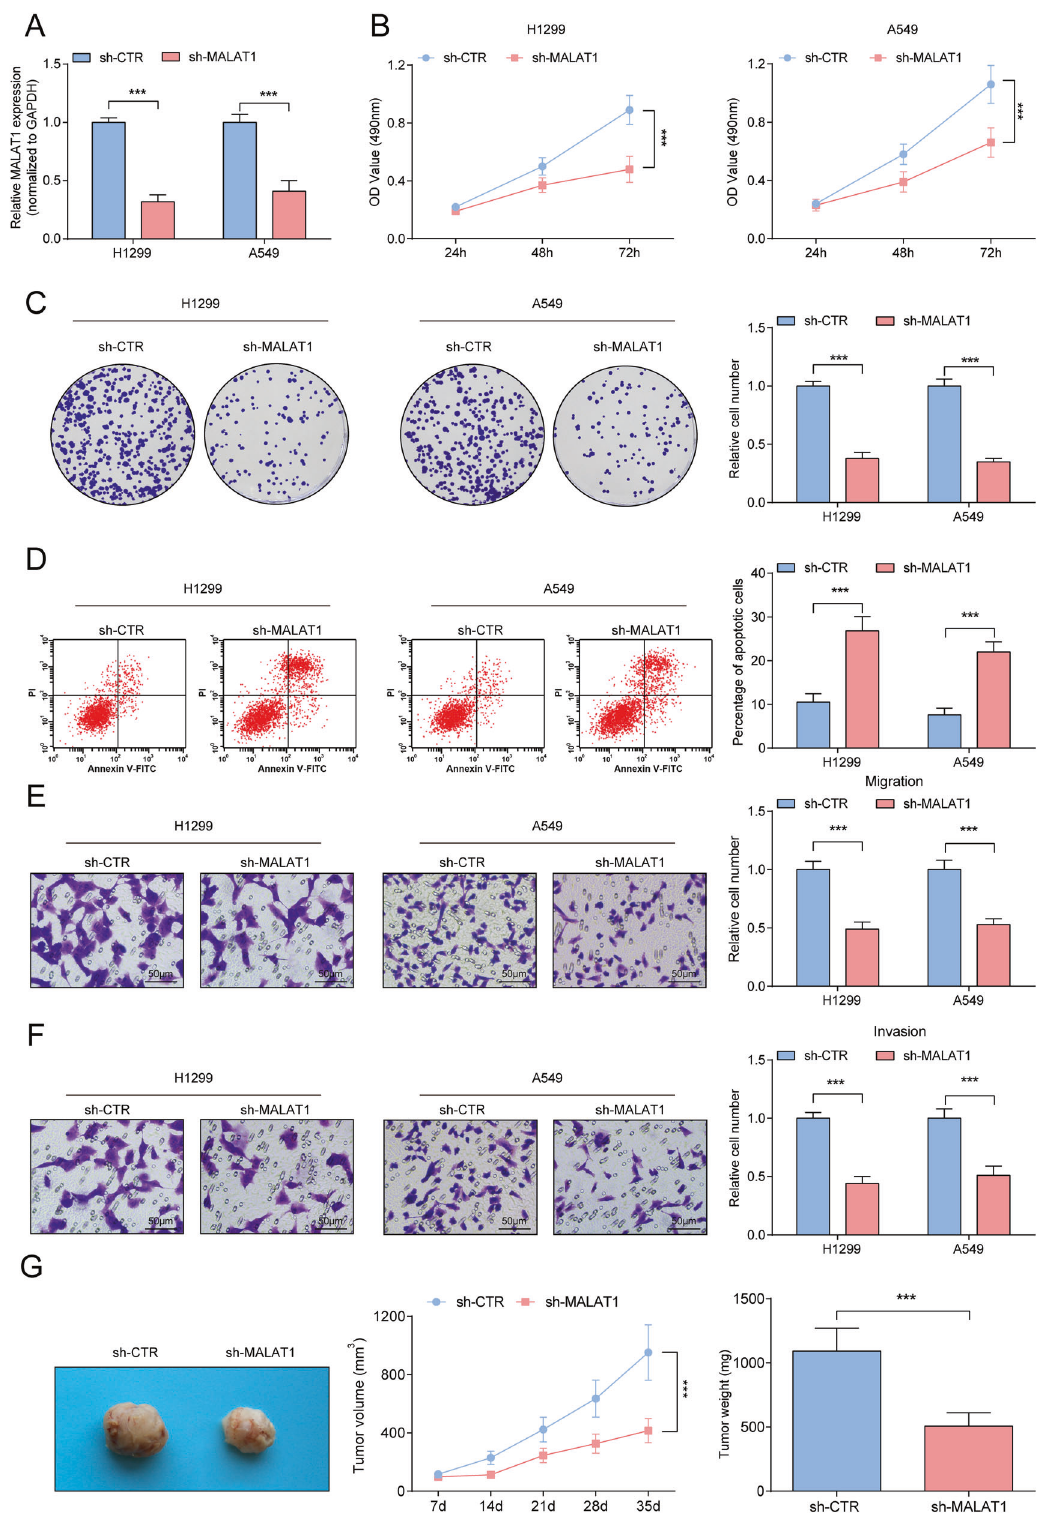
Fig. 3 Inhibitory effects of down-regulated MALAT1 on NSCLC. A RT-qPCR analysis of MALAT1 level after down-regulating MALAT1; B MTT measured the growth curve of A549 and H1299 cells after downregulating MALAT1; C Colony formation assay measured colony formation ability of A549 and H1299 cells after downregulating MALAT1; D Flow cytometry measured A549 and H1299 cell apoptosis after downregulating MALAT1. E , F Transwell measured cell migration and invasion ability after downregulating MALAT1. G Tumor formation assay evaluated tumor volume and weight after downregulating MALAT1. *** P < 0.001; Data statistics was by t -test.